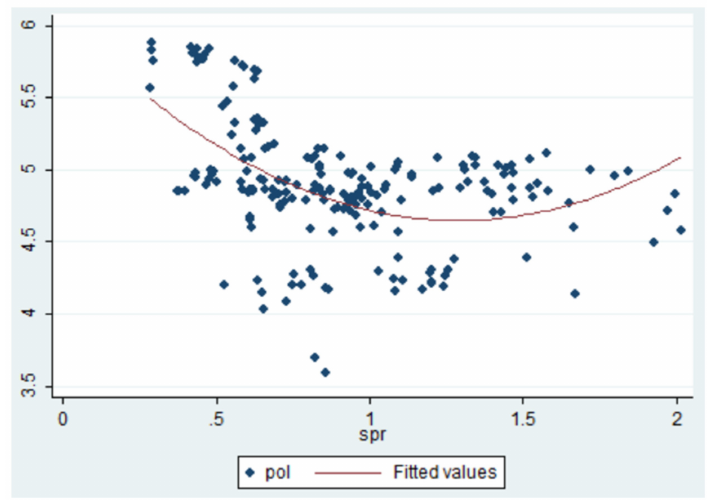
Figure 3. Quadratic fitting analysis of urban sprawl and environmental pollution.